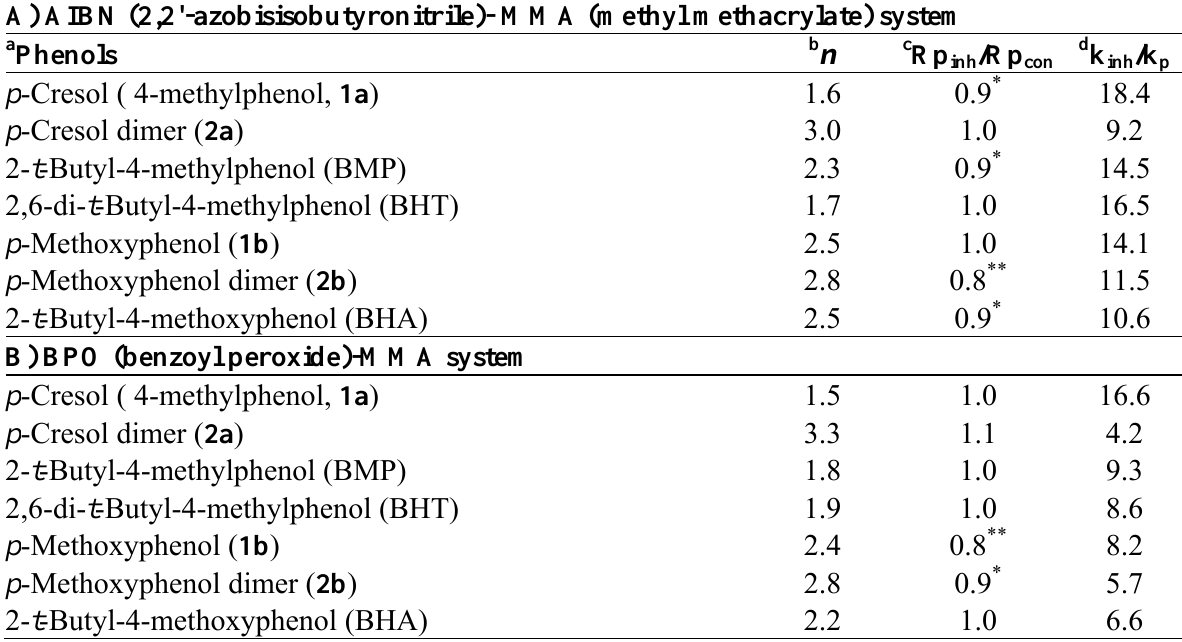
Table 1. Radical-scavenging activity for p -cresol and p -methoxyphenol related